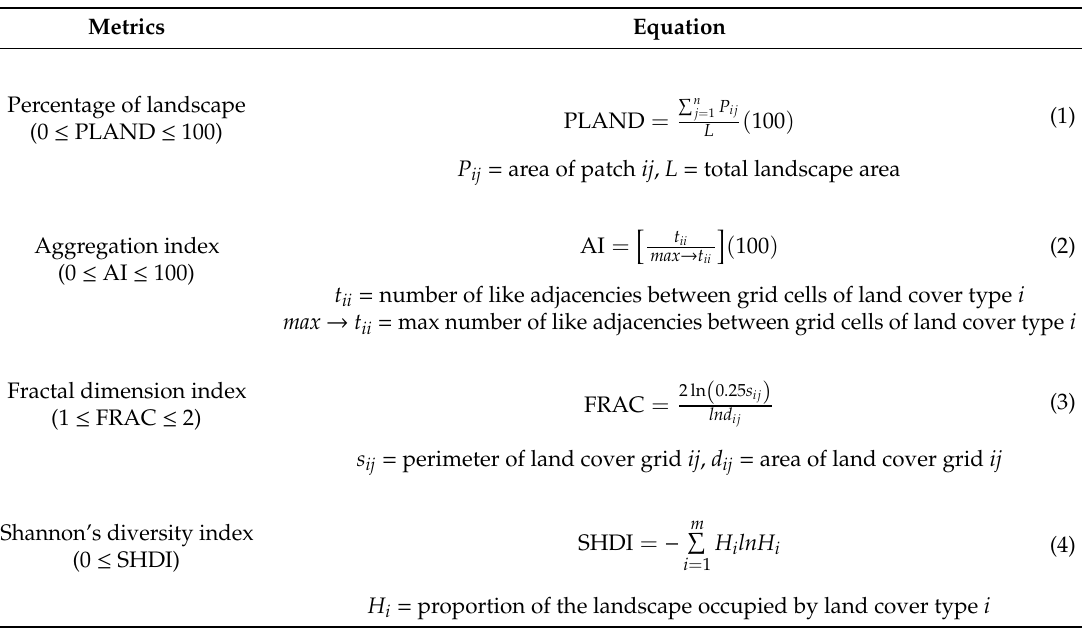
Table 1. Landscape metric equations used to detect spatial patterns of urbanization. Metrics Equation